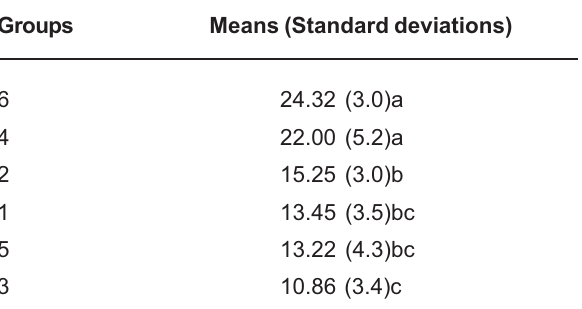
Equal letters = no statistically significant